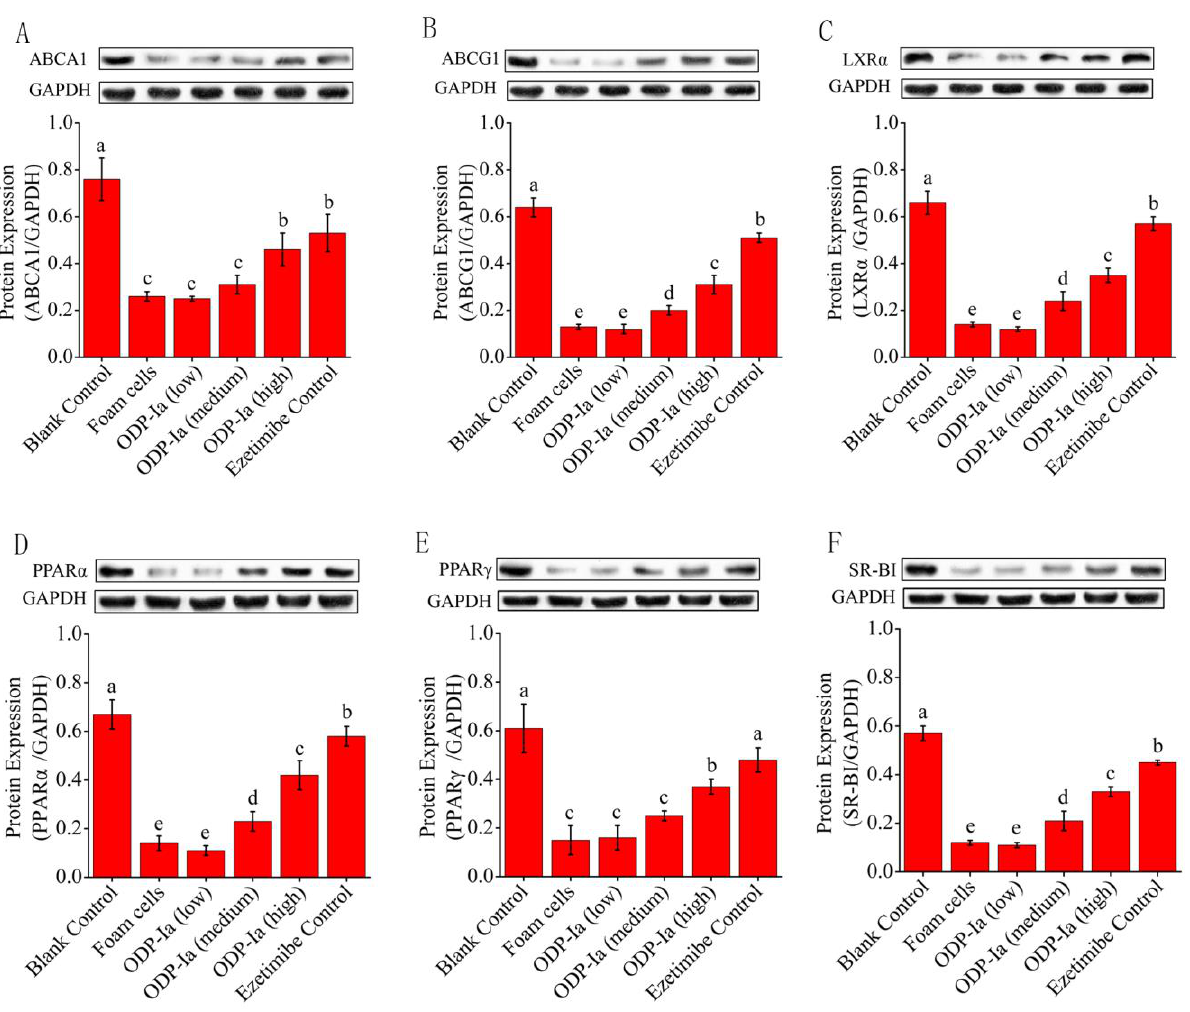
Figure 6. Effect of ODP-Ia on protein expression of ABCA1, ABCG1, LXR α , PPAR α , PPAR γ and SR-BI in THP-1 macrophage-derived foam cells. Dates in figure represent the density values of each band (mean ± SD, n = 9). ( A ) ABCA1 protein expression level. ( B ) ABCG1 protein expression level. ( C ) LXR α protein expression level. ( D ) PPAR α protein expression level. ( E ) PPAR γ protein expression level. ( F ) SR-BI protein expression level. Different superscript letters indicate multiple comparisons with significant differences (SNK-q test, p <